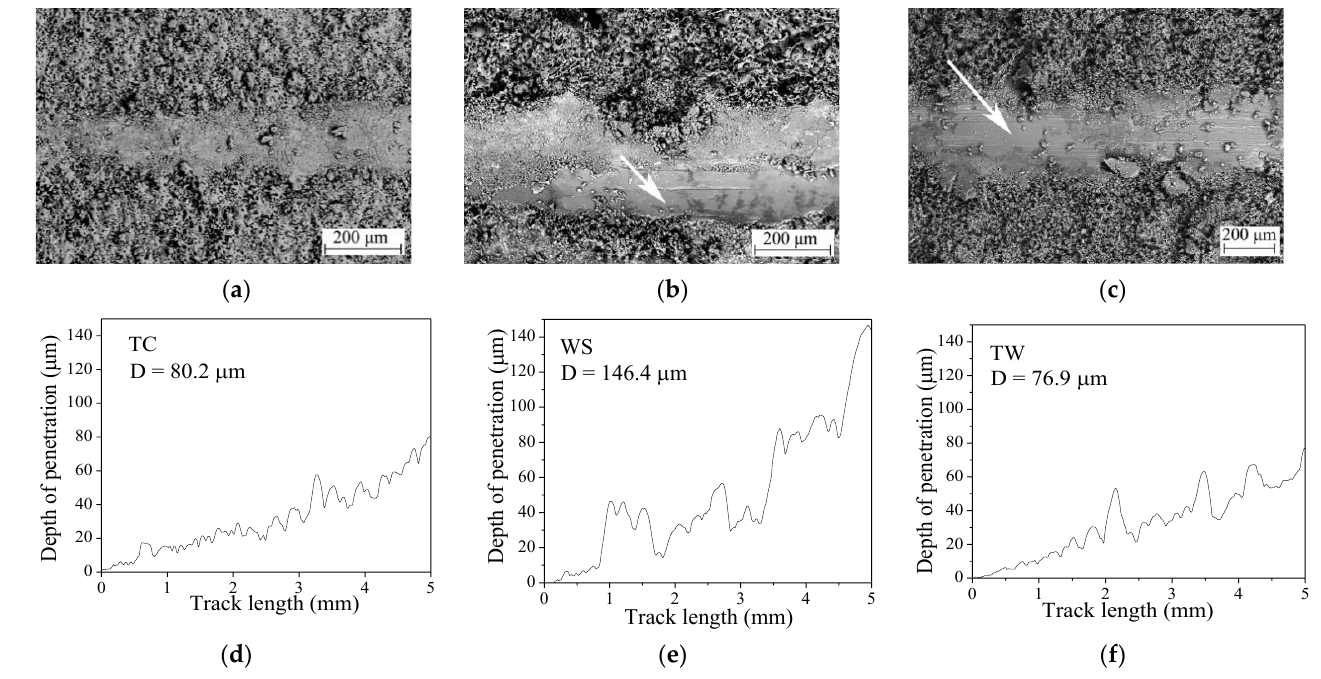
Figure 12. SEM-images of the zone of the substrate damage ( a – c ), the depth of the indenter penetra- tion into the coatings along the track length ( d – f ).